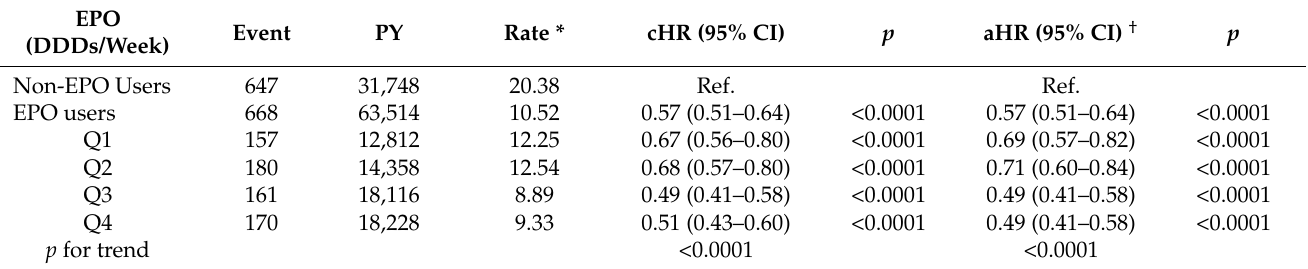
Table 2. Incidence and hazard ratios of age-related macular degeneration in hemodialysis patients by quartile dosage of erythropoietin.